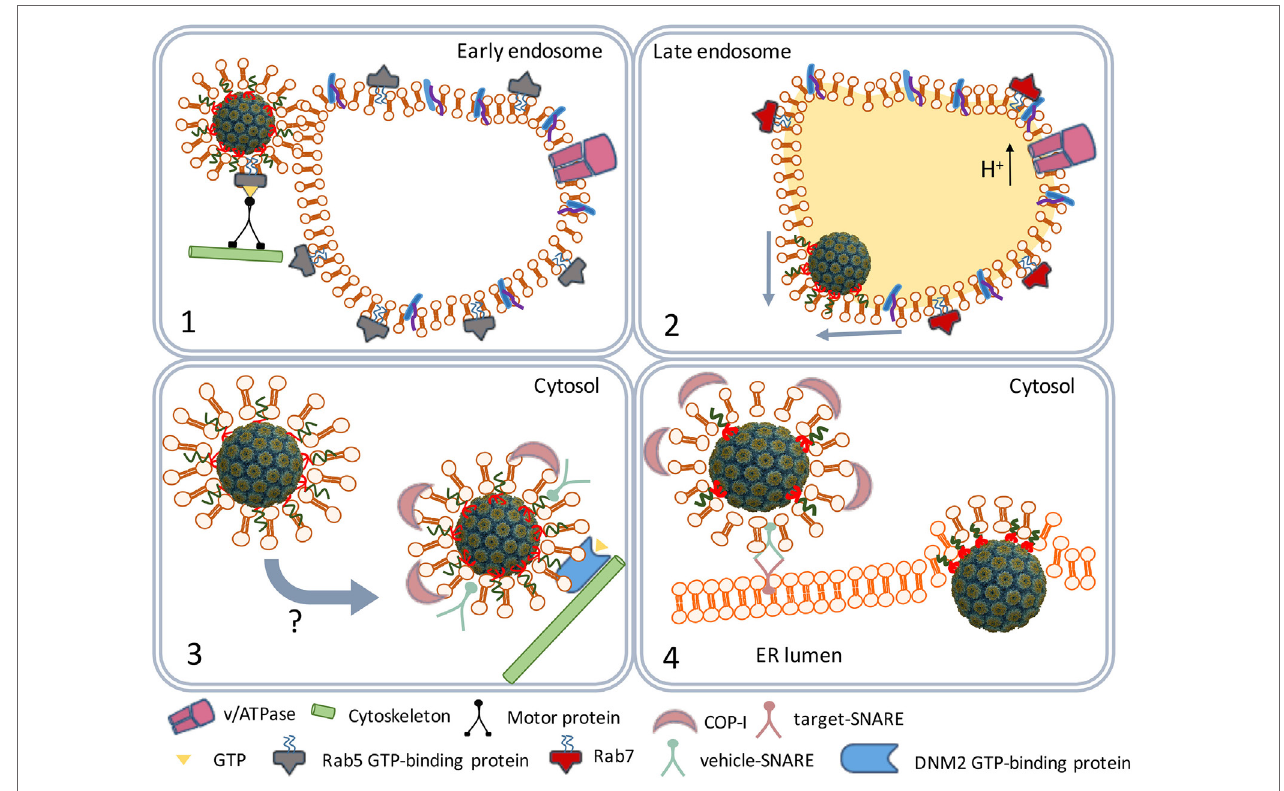
FigURe 3 | SV40 endocytosis and transport to the endoplasmic reticulum (ER). Scheme depicting the traffic of SV40-containing caveolar vesicles to early endosomes (1). The maturation of endosomes and fusion with lysosomes to endolysosomes (2). The traffic of coat protein I (COPI)-decorated vesicles to the ER (3). ER internalization